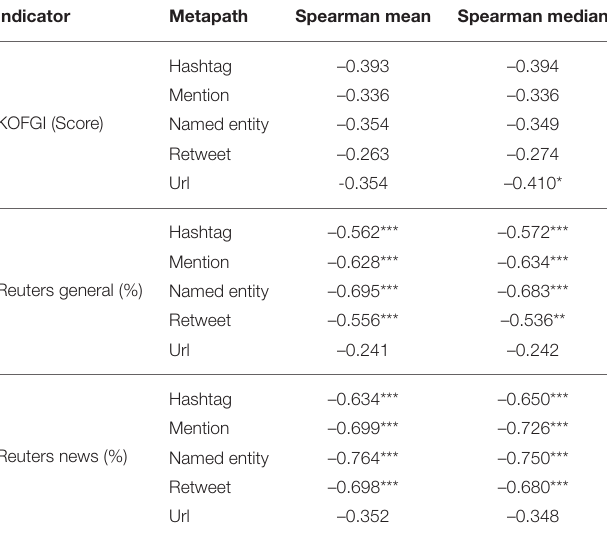
TABLE 3 | Country-wise rank correlation (Spearman’s Rank Correlation) of mean and median shares with KOF Globalization Index 2019 (KOFGI) social dimensions, Reuters social media usage 2020 (any purpose/general usage); and Reuters social media usage 2020 (news) by